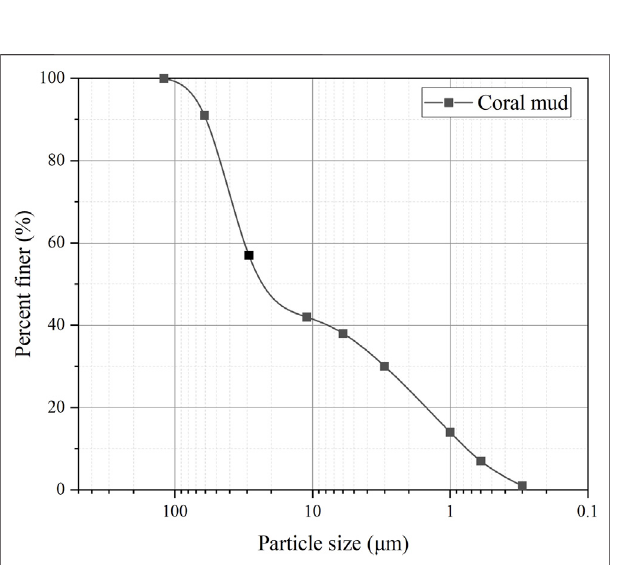
FIGURE 1 | Particle size distribution of coral mud.